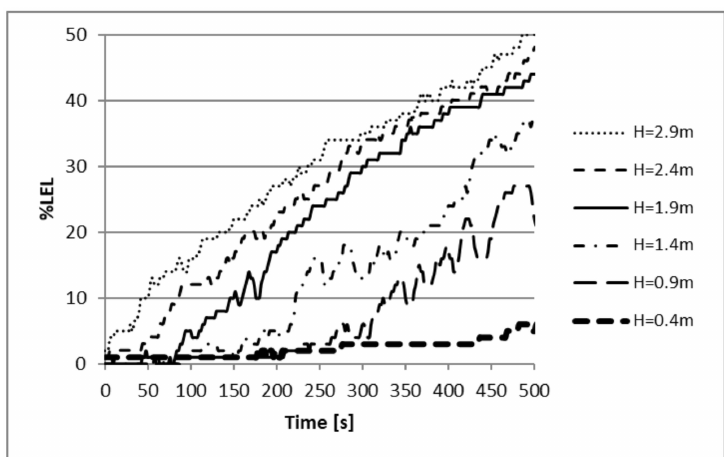
Figure 4. Hydrogen condensation range in the Test 1.